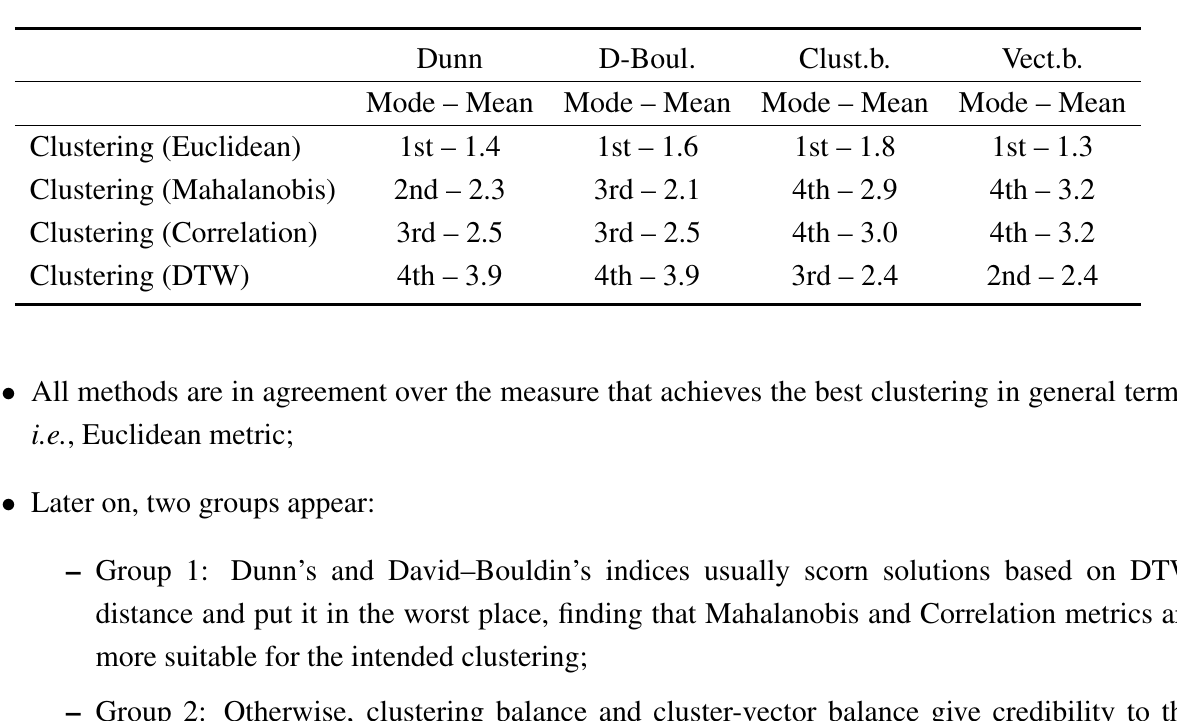
Table 2. Validity techniques evaluations, statistical Mode and